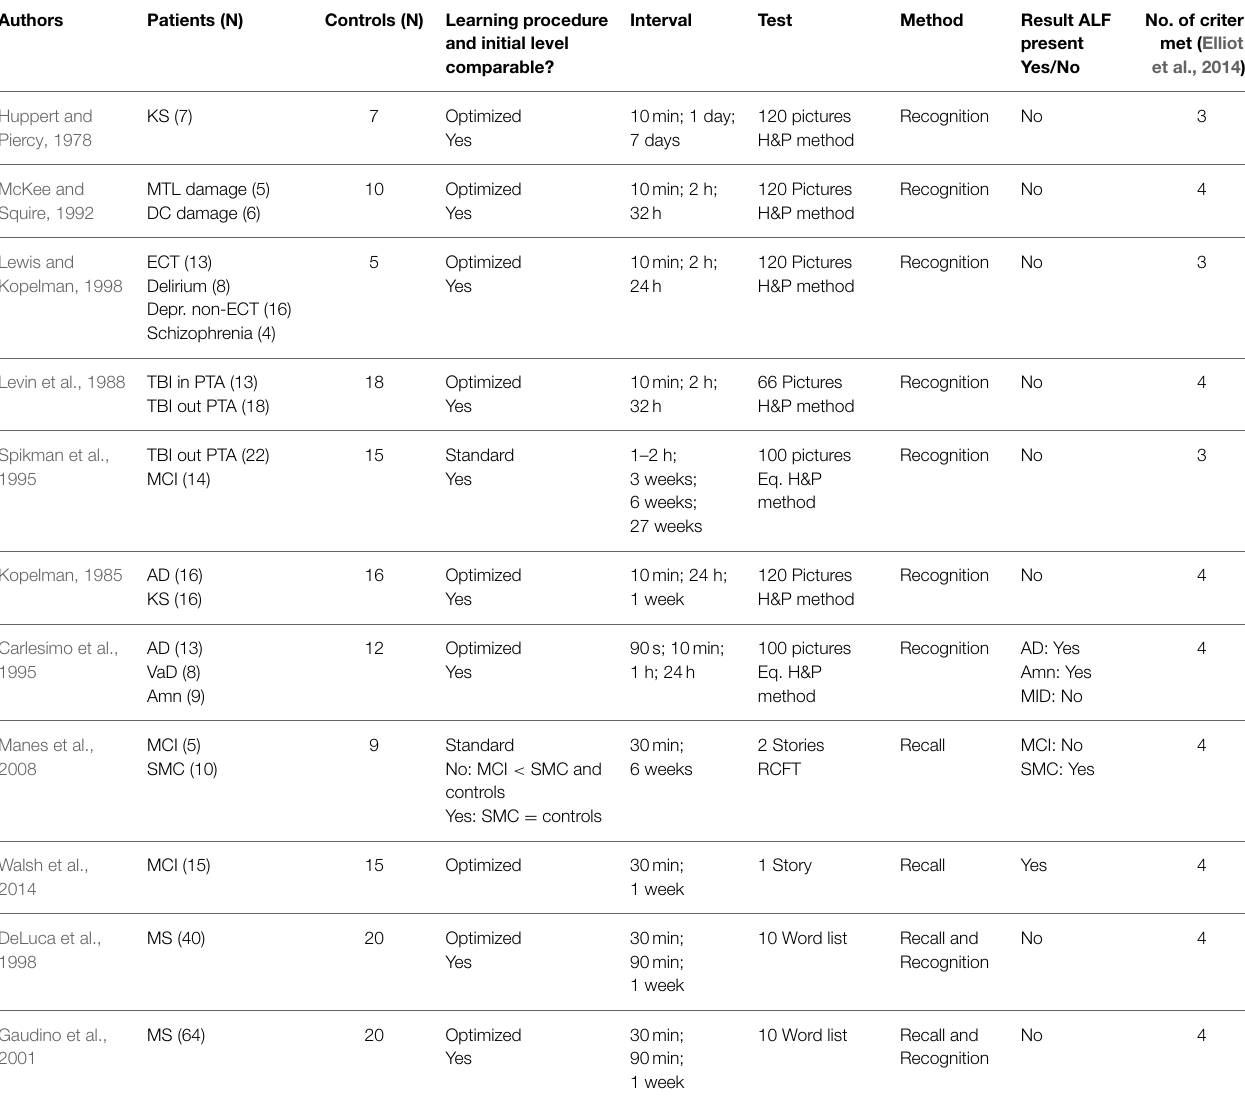
TABLE 1 | Characteristics of the studies. Authors Patients